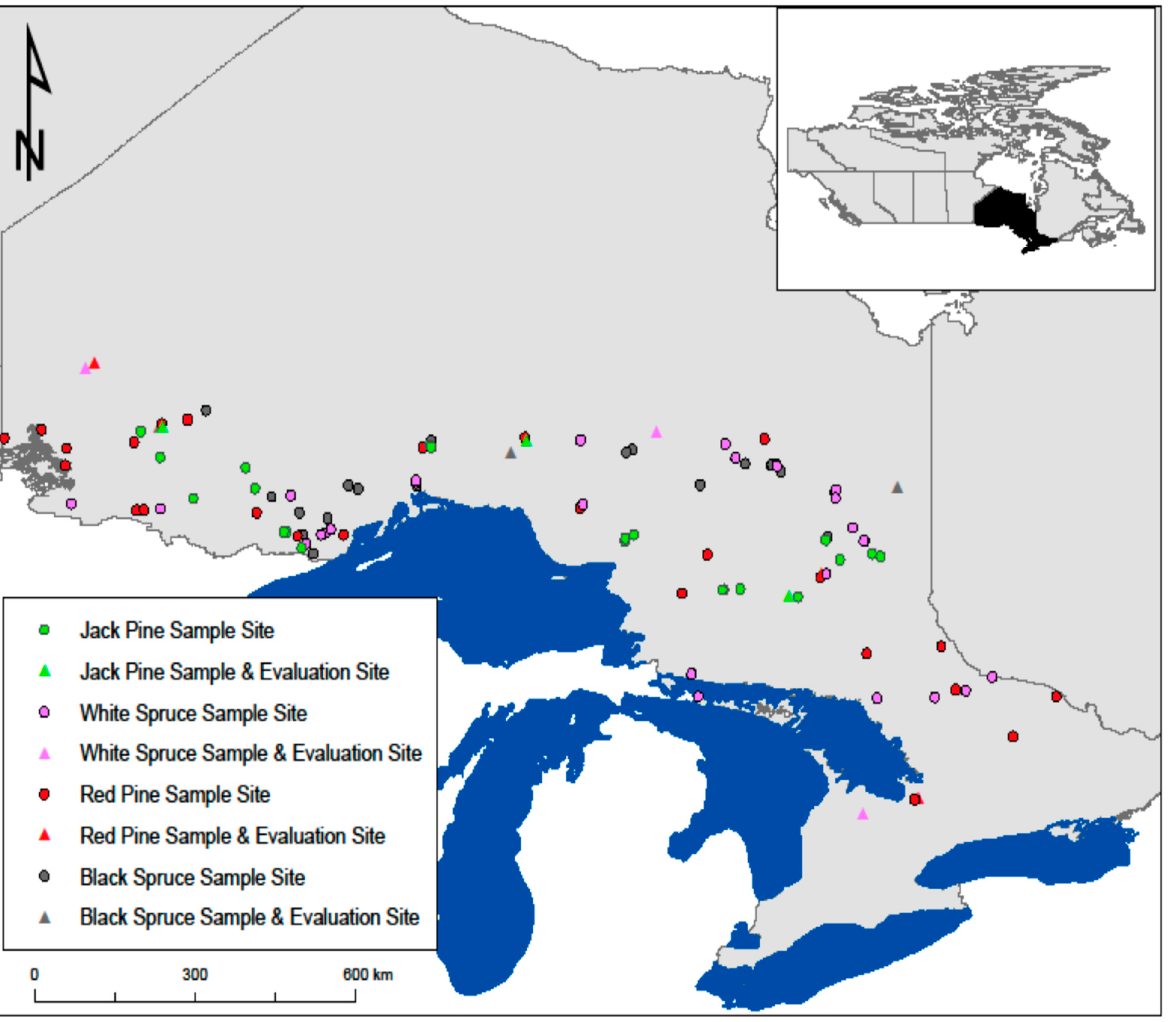
Figure 1. Distribution of jack pine and black spruce plantation sites sampled across Northern Ontario, Canada. Latitude and longitude ranged from 47° N to 50° N and 80° W to 92° W, respectively.